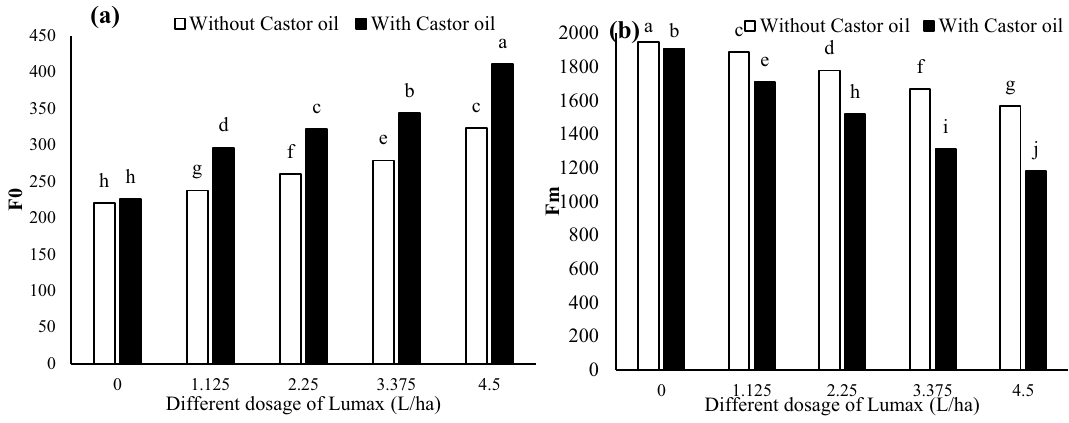
Figure 5. Changes in F0 ( a ) and Fm ( b ) of Solanum gigrum in response to different doses of Mesotrion + S-metolacholor + Terbuthylazine with and without Castor oil. Each value is the mean of four replicates. Different letters represent significant differences ( P < 0.05).